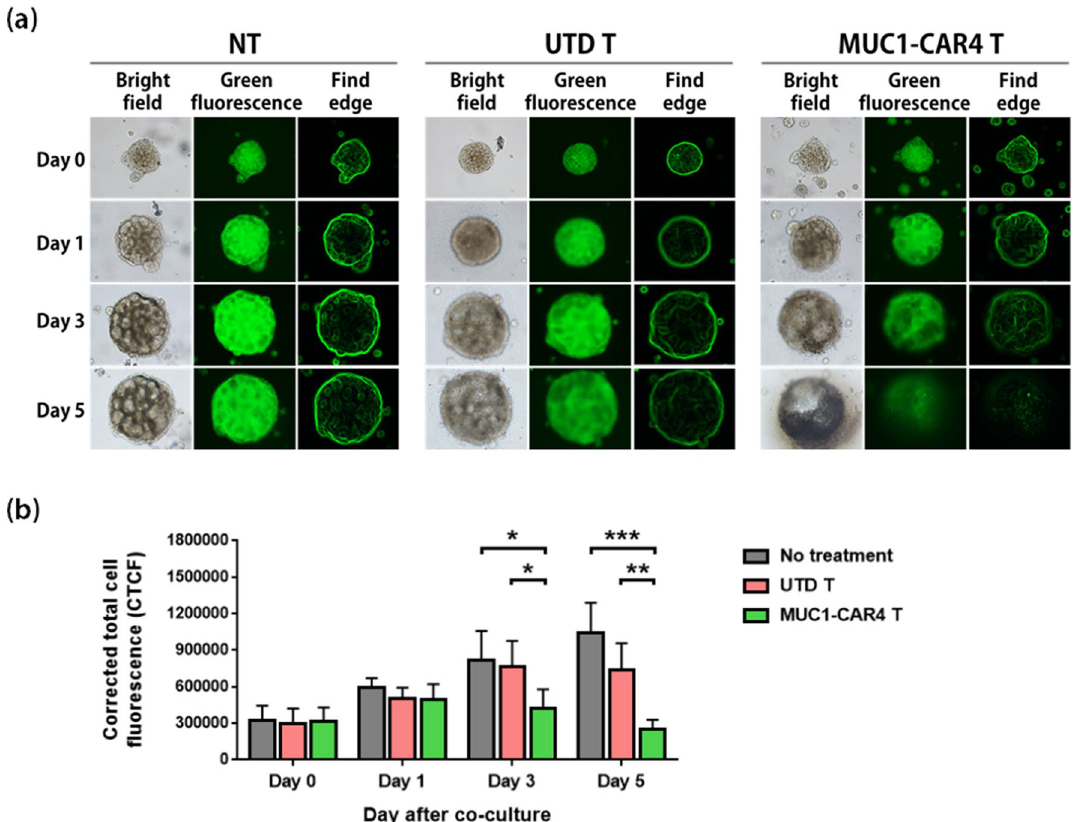
Figure 7. Anti-tumor effect of anti-MUC1-CAR4 T cells against MUC1-expressing KKU-213A spheroids. ( a ) Representative results of KKU-213A spheroids expressing a green fluorescence protein; left panel: no treatment (NT); middle panel: spheroids co-cultured with untransduced T cells (UTD T); right panel: spheroids co-cultured with anti-MUC1-CAR4 T cells (E:T ratio of 10:1). The spheroids were captured under a fluorescence microscope at 10 × objective lens. ( b ) The bar graphs represent summarized data of corrected total cell fluorescence (CTCF) from 4 independent donors (mean ± SD). The statistical differences were analyzed by Student t -test (asterisks indicate p -values: * p < 0.05, ** p < 0.01, *** p <